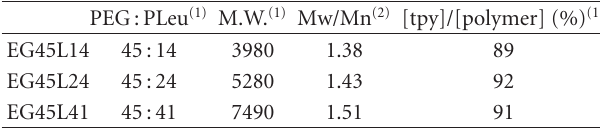
Figure 2: NMR spectrum of the final product, tpy-PEG-PLeu. The polymerization degree of the peptide segment, that is, the molecular weight, and the fraction of the polymer chain having the tpy unit at the end in Table 1 were obtained by NMR measurements. The polydispersity index, Mw/Mn, was obtained by GPC measurements. Table 1: Characterization of